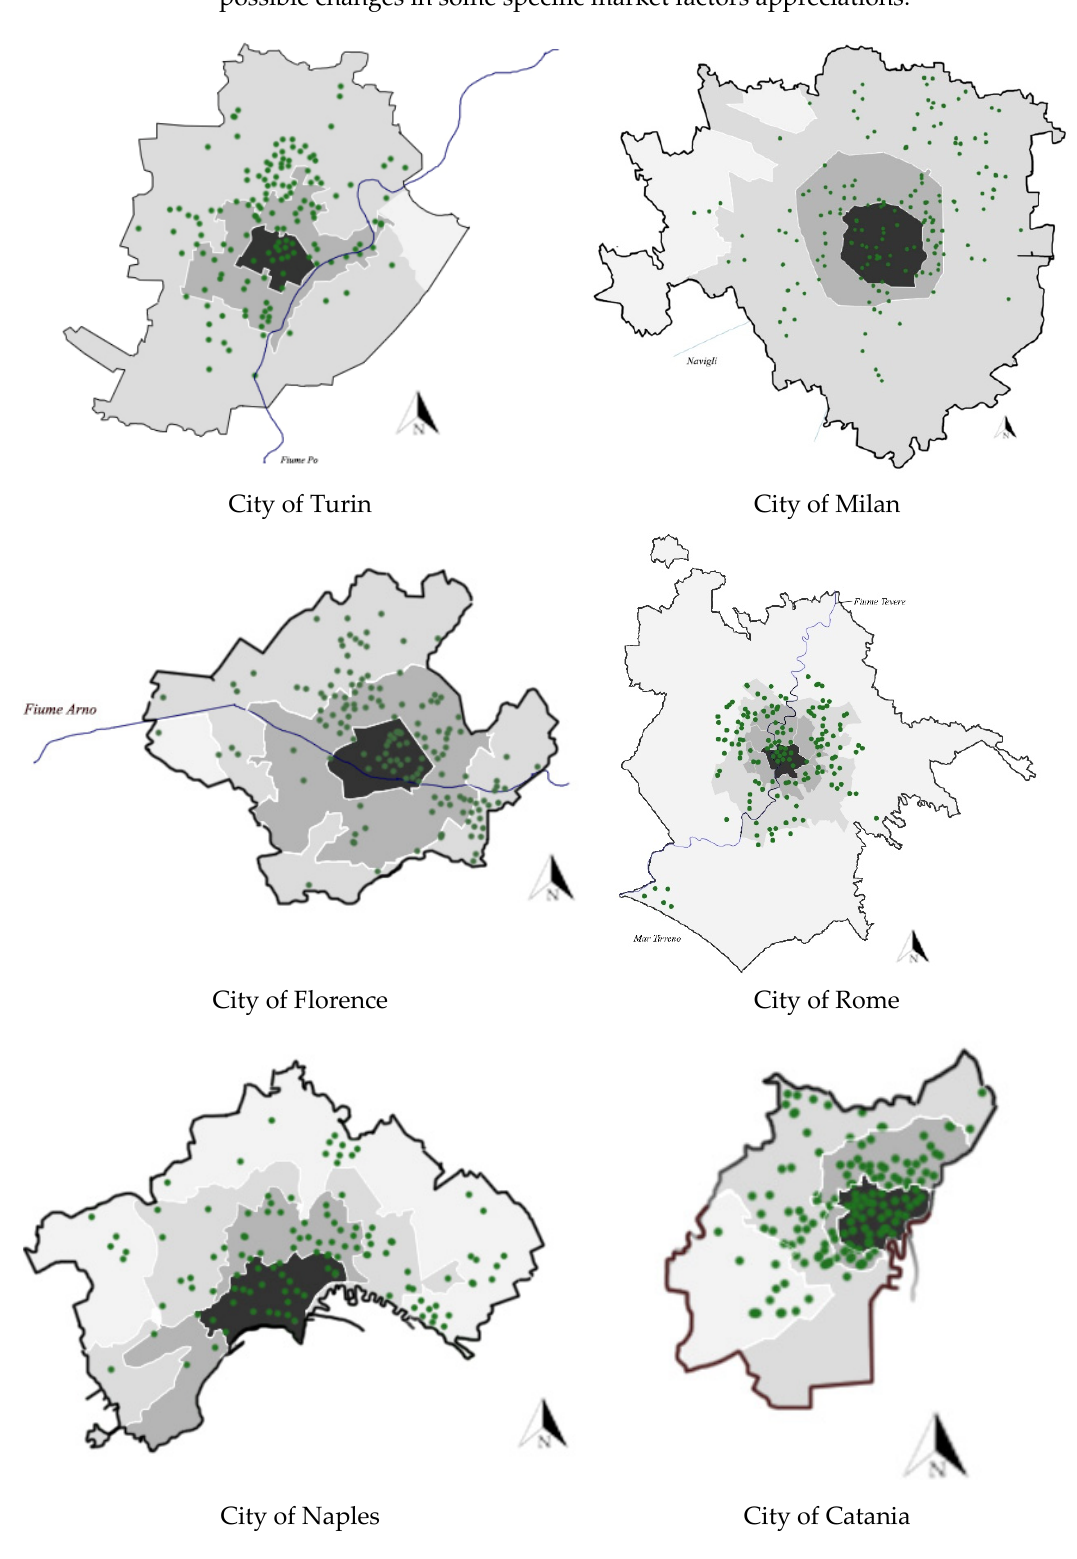
Figure 2. Location of the study sample properties (indicated by green) selected for each Italian city for the Phase I “pre-COVID-19 pandemic”.